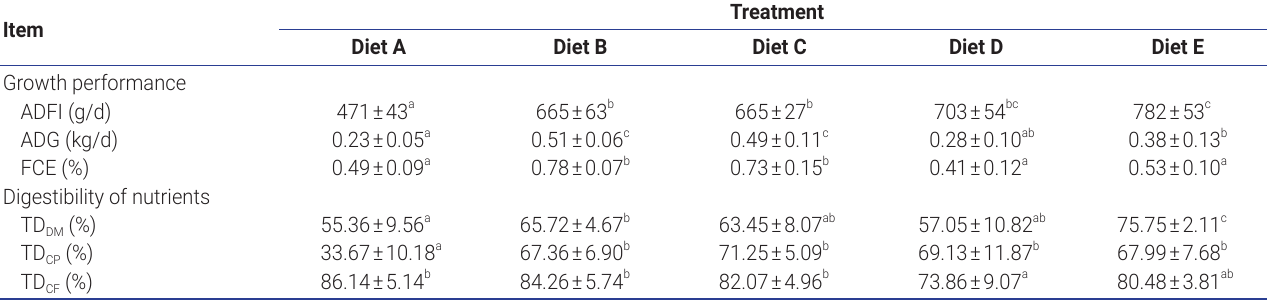
Table 7. Effects of different levels metabolizable glucose on growth performance and nutrients digestibility in piglets in Exp